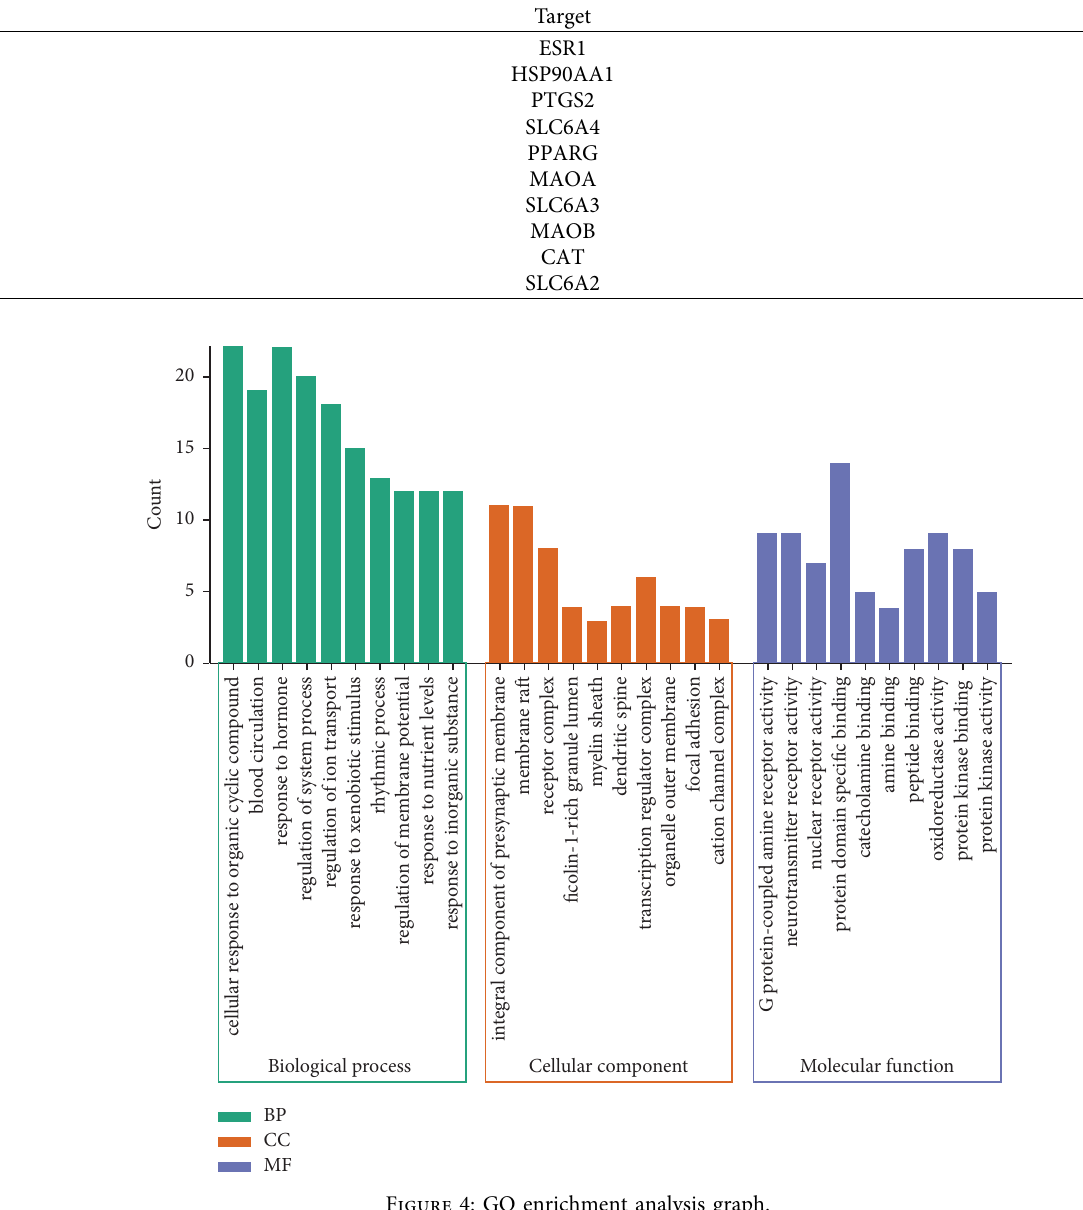
Table 2: Key targets of the bitter almond antioxidant PPI